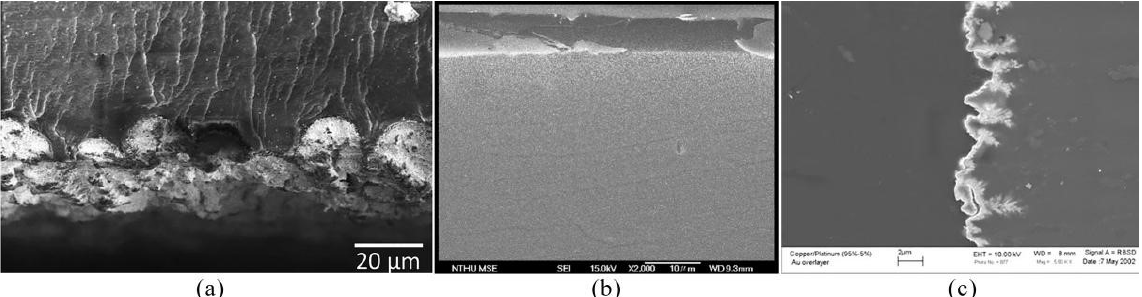
Figure 4. Cross-sectional morphology of IPMC prepared by different electroless plating